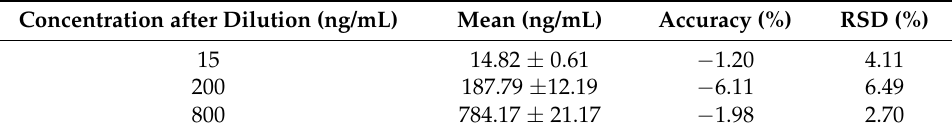
Table 3. The diluted reliability of RPDQ in plasma ( n =